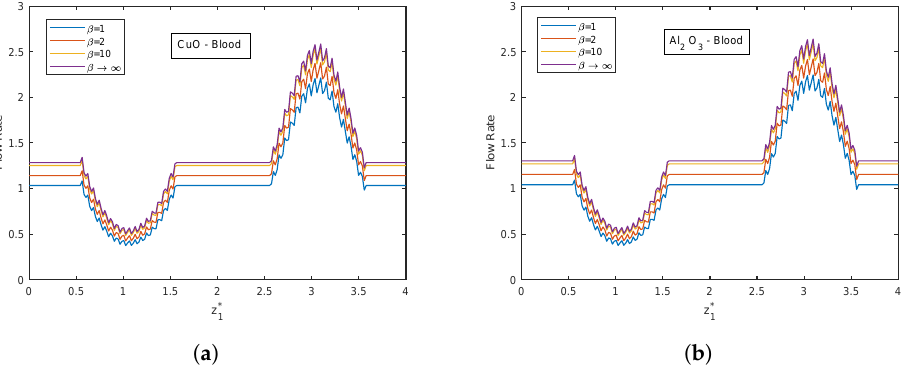
Figure 27. Flow rate profiles of Casson fluid parameter β for ( a ) CuO-nanoparticles, ( b ) Al 2 O 3 -nanoparticles at t ∗ = 1